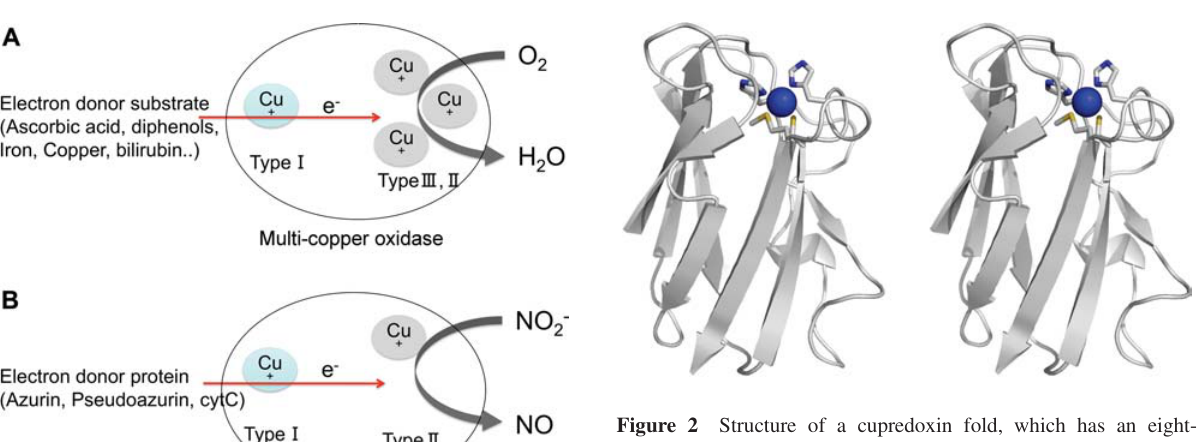
Figure 2 Structure of a cupredoxin fold, which has an eight- stranded Greek key b -barrel